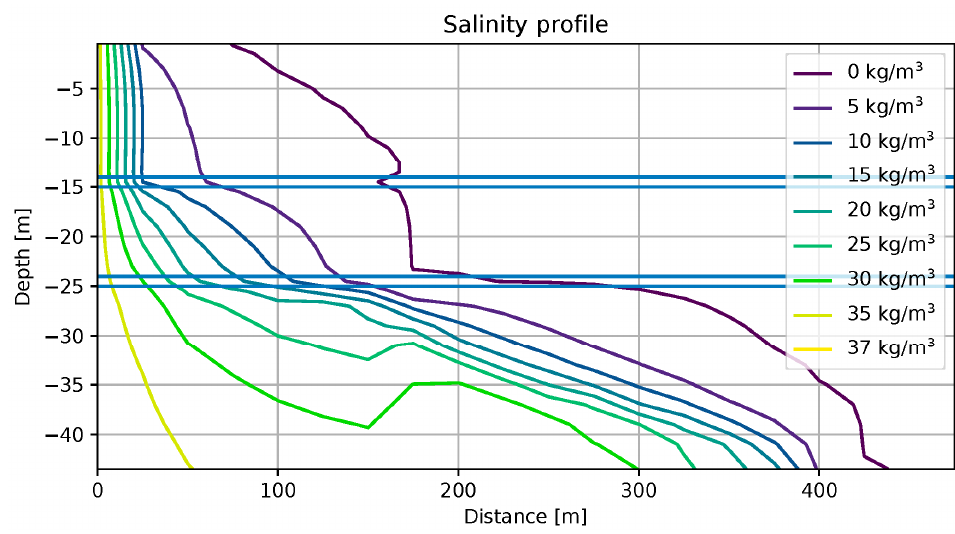
Figure 12. Modelled seawater wedge.